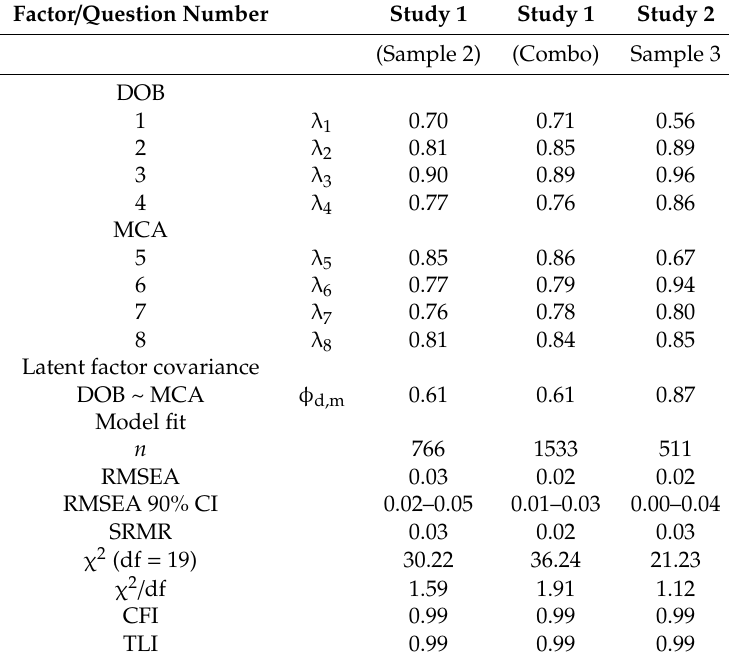
Table 2. Factor loadings and fit indices in confirmatory factor analysis (CFA) for the Cybercrime Rapid Identification Tool (CRIT), by study (see Figure 1).